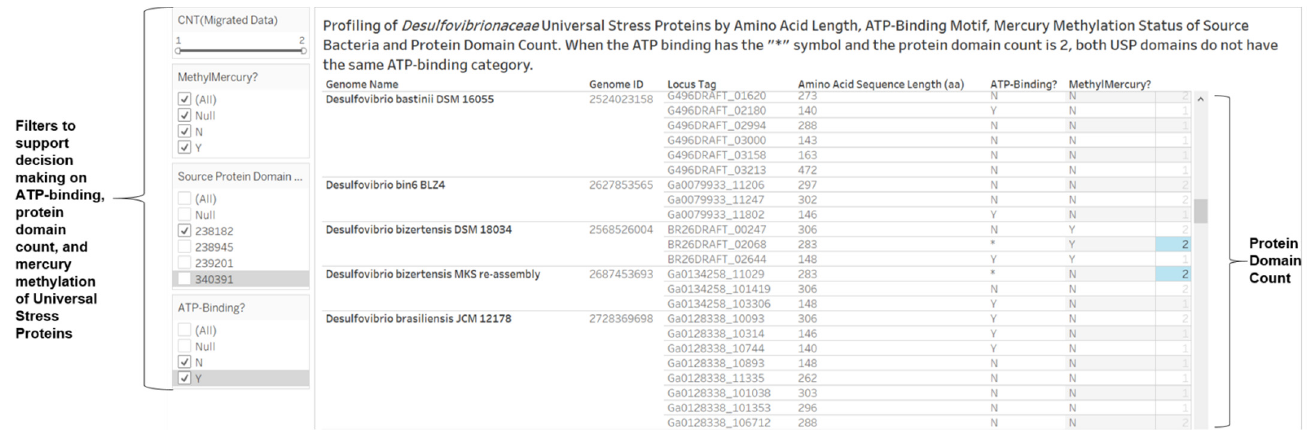
Figure 5. Profiling of Desulfovibrionaceae universal stress proteins by amino acid length, ATP-binding motif, mercury methylation status of source bacteria and protein domain count. When the ATP-binding has the “*” symbol and the protein domain count is 2, both USP domains do not have the same ATP-binding category (BR26DRAFT_02068 and Ga0134258, which are 283 aa USP of strains of Desulfovibrio bizertensis ). Protein domain count of “1” indicates protein sequence has only one USP domain.